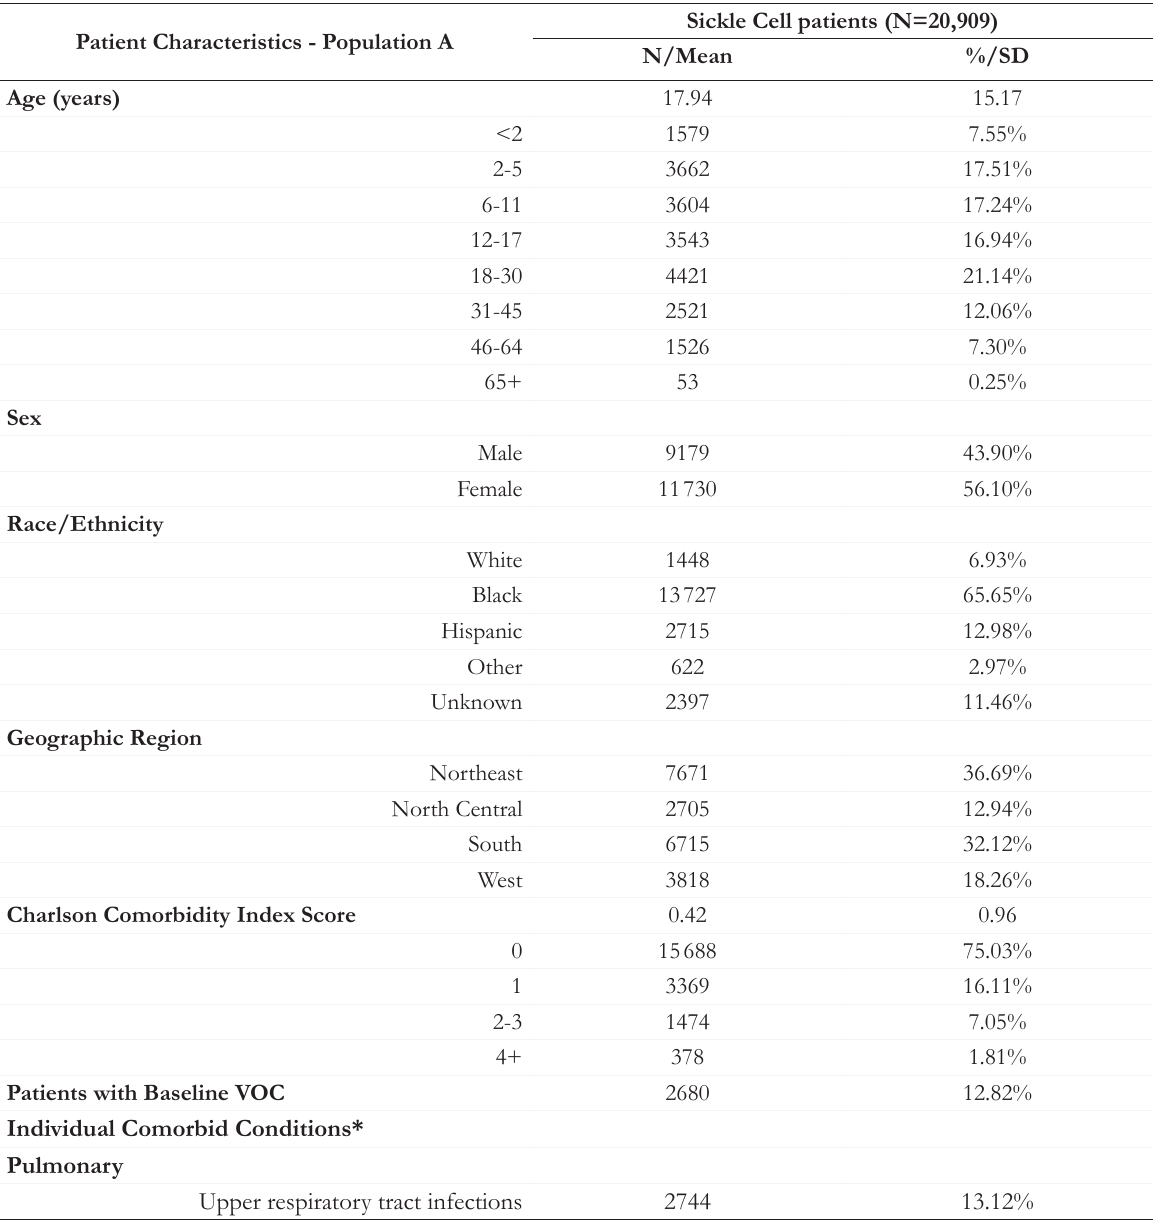
Table 1. Baseline Characteristics for Overall SCD Patients Patient Characteristics - Population